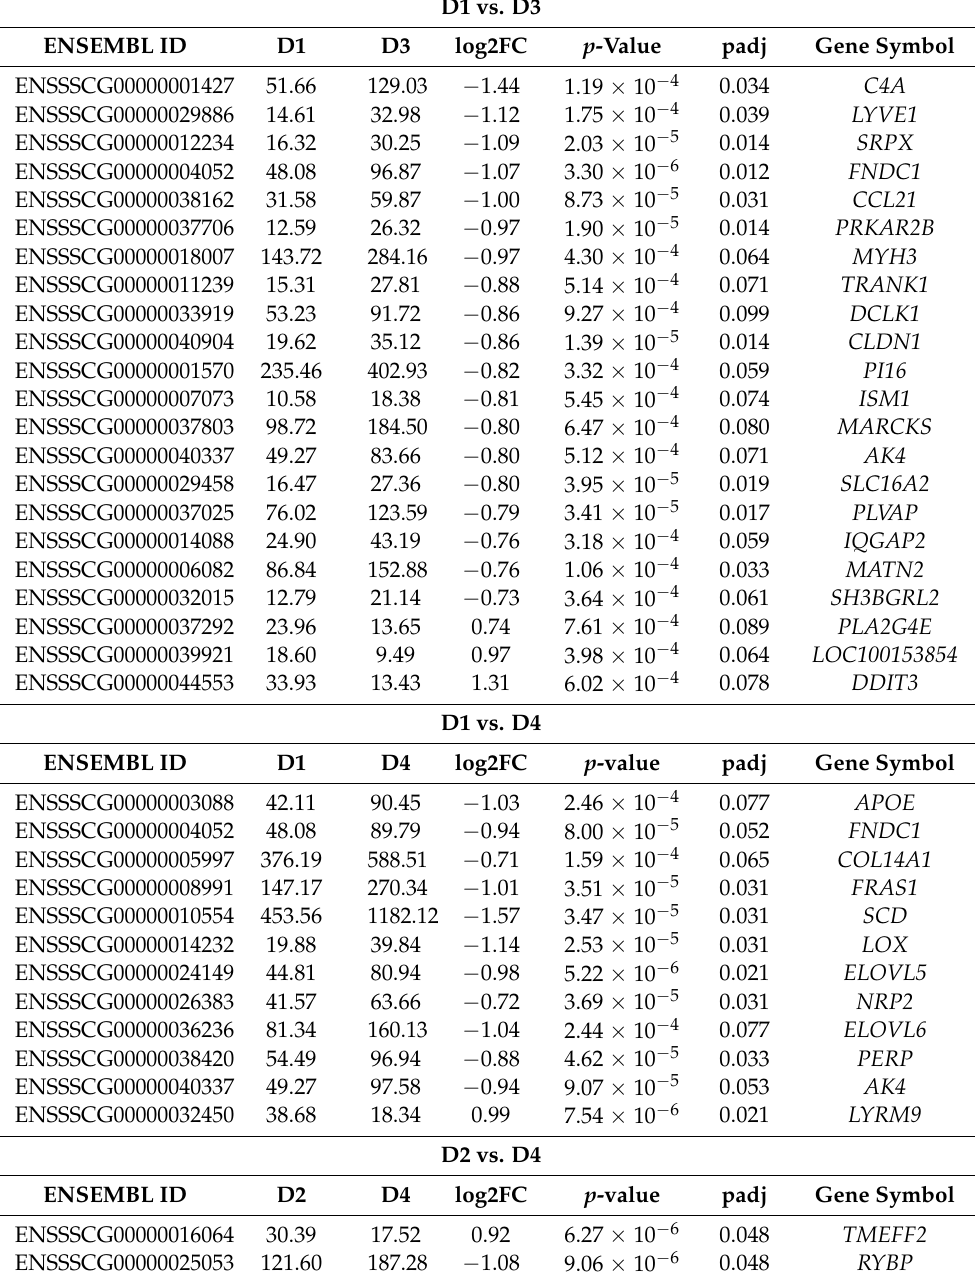
Table 2. Differentially expressed genes (DEGs) were obtained from D1 vs. D3, D1 vs. D4, and D2 vs. D4 comparisons. For each DEG, the ENSEMBL identity number, the mean of the normalized counts, the log2 Fold Change (log2FC), the raw p -values, the adjusted p -values (padj), and gene symbol are reported. D1 vs.